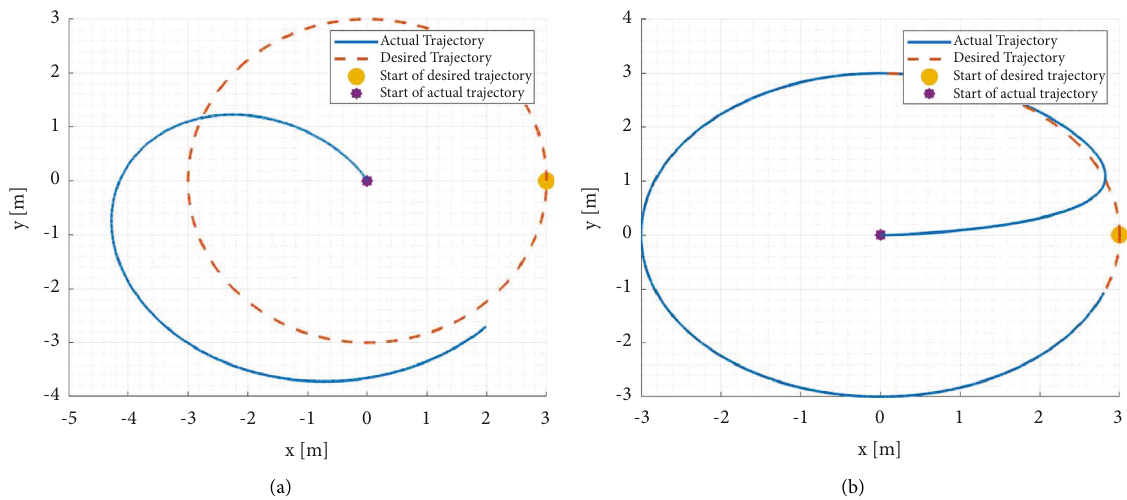
Figure 20: The trajectory for PD (a) and FBL with PD control (b) after 15 seconds.